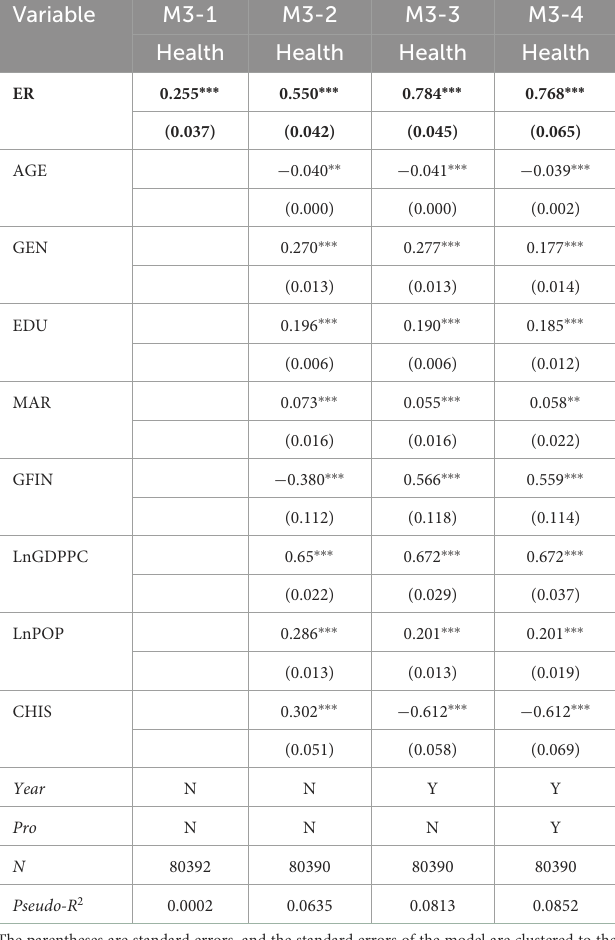
TABLE 3 Regression